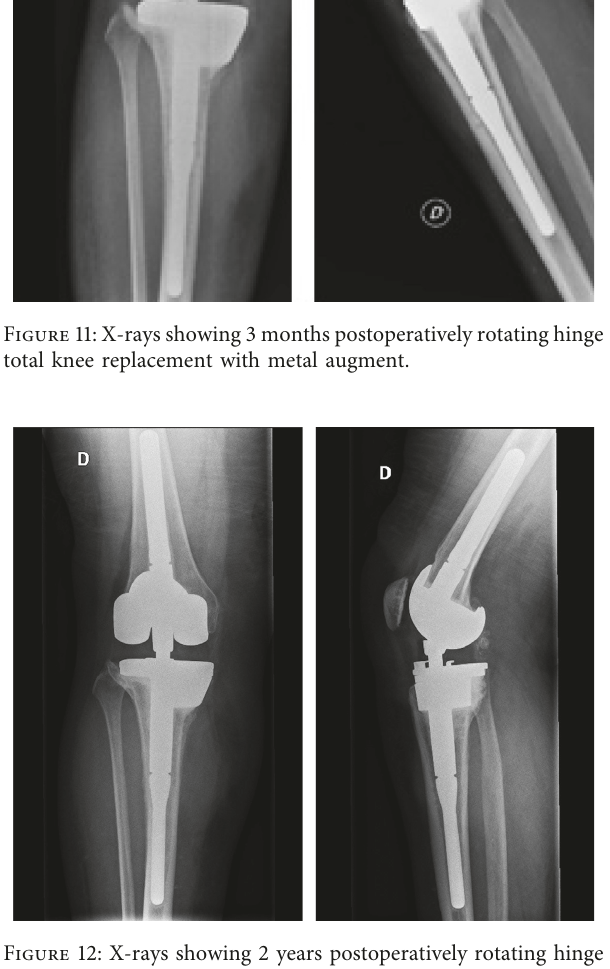
Figure 10: September 2013, X-rays showing postarticular resection and implantation of cement spacer.